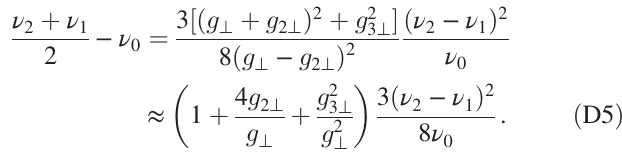
0 ). (b) Points ( B x y ¼